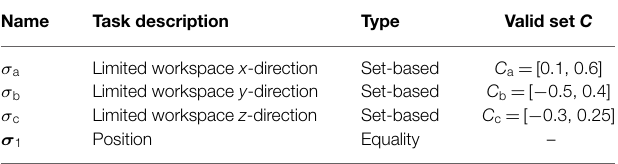
TABLE 7 | Implemented tasks in example 2 sorted by decreasing priority .